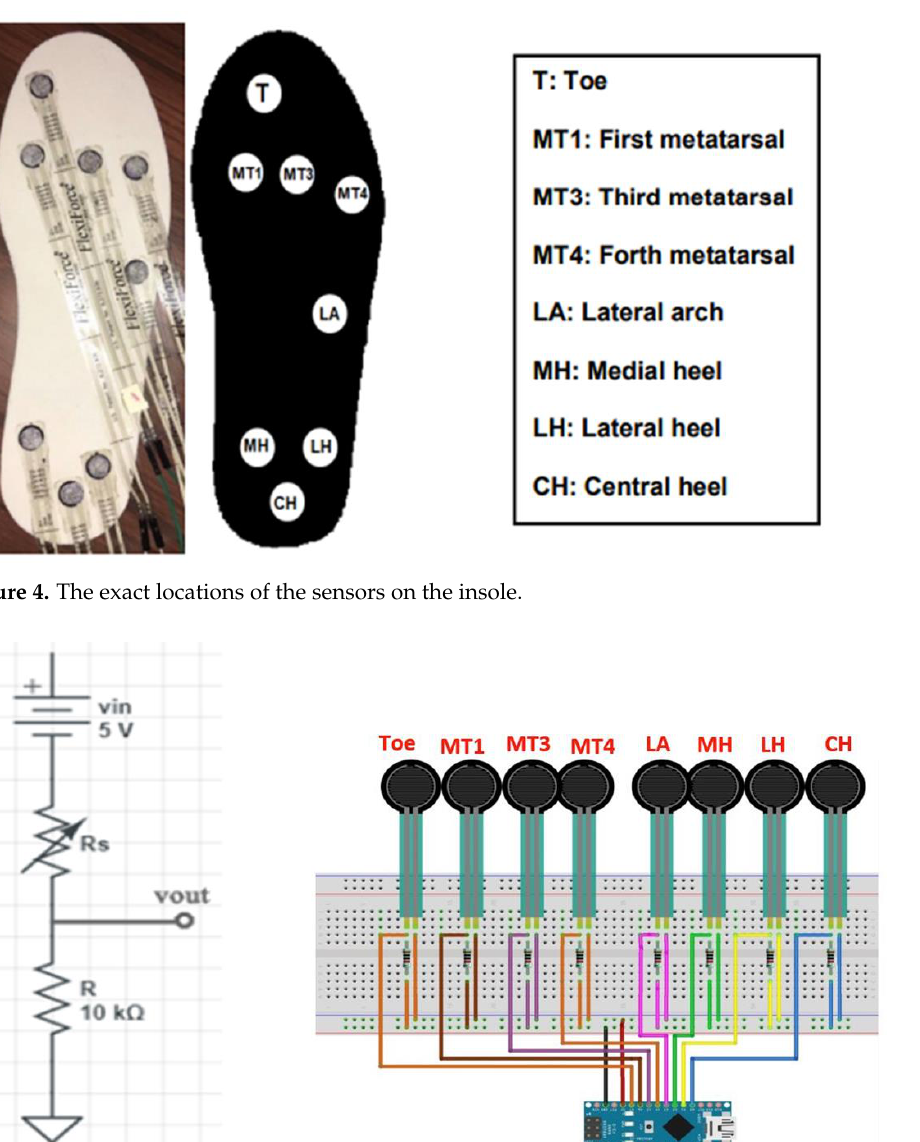
Figure 5. The signal conditioning ( a ) the electrical circuit for the sensor ( b ) the wiring